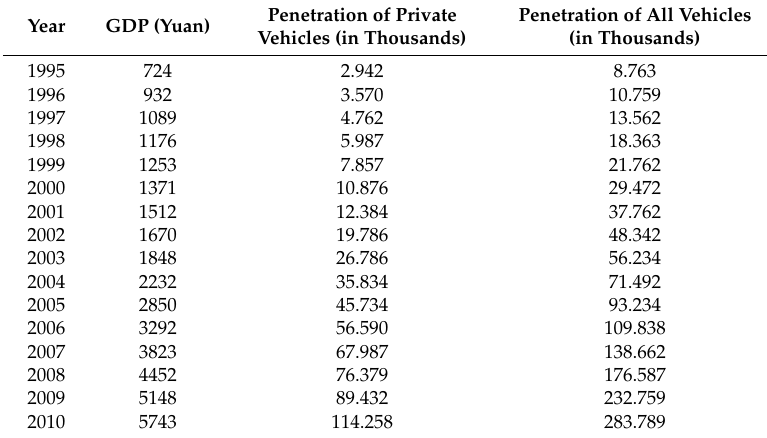
Table 1. The general situation for the GDP and the penetration of vehicles.